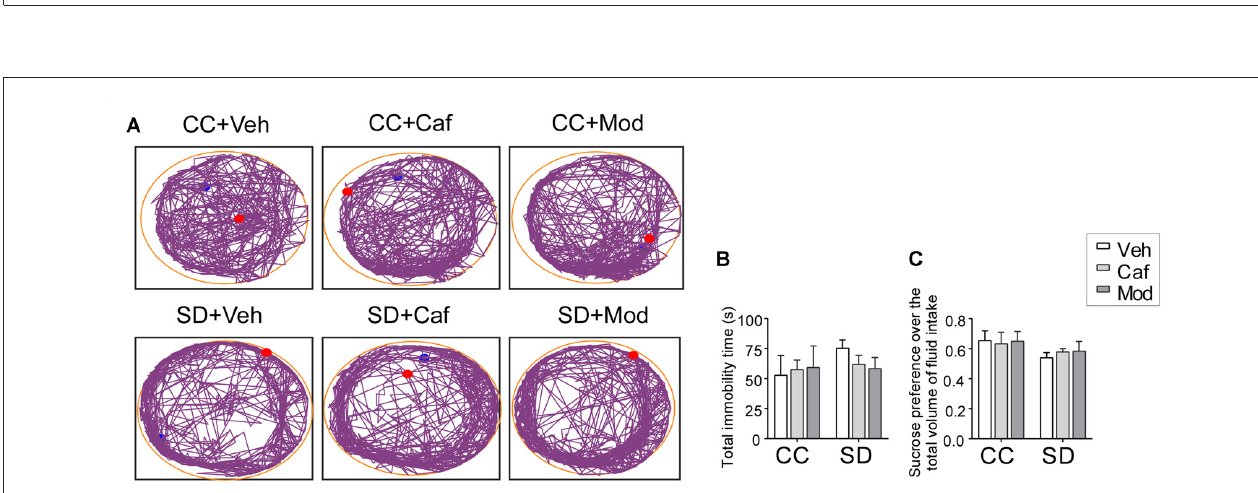
FIGURE 3 | Assessment of the depressive behavior following caffeine/modafinil treatment during SD. (A) Track plot of the rats during forced swim test (FST) test; (B) total immobility time; (C) sucrose preference over the total volume of fluid intake. Two way ANOVA followed by Tukey post hoc with multiple comparison test was applied for statistical comparison between groups. Blue dot represented the starting point and the red dot represented the end point of the test.